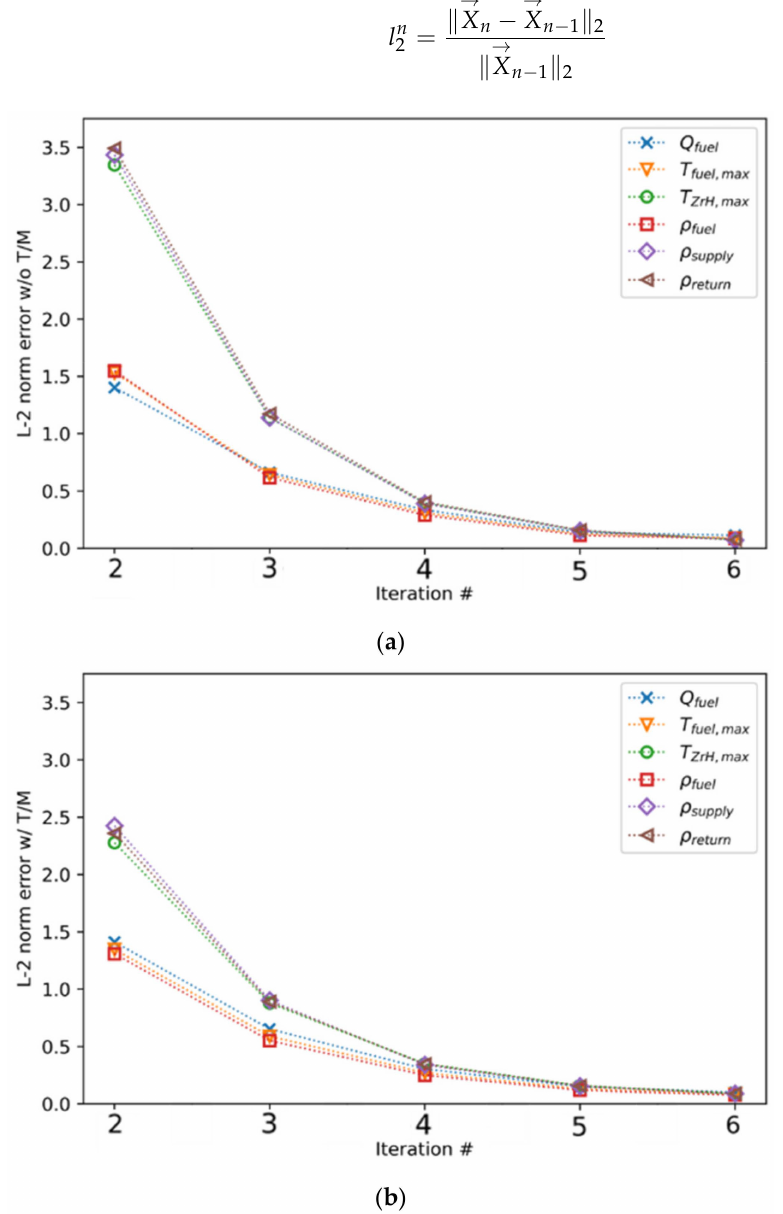
Figure 6. Comparison of L-2 norm error convergence ( a ) w/o T/M feedback; ( b ) w/ T/M feedback. → X is the spatial distribution of interest for consecutive iterations n − 1 In Equation (25), and n [27]. The trends in Figure 6 demonstrate that temperature, density, and power spatial distributions converged after the sixth iteration. Figure 7 details the excess reactivity